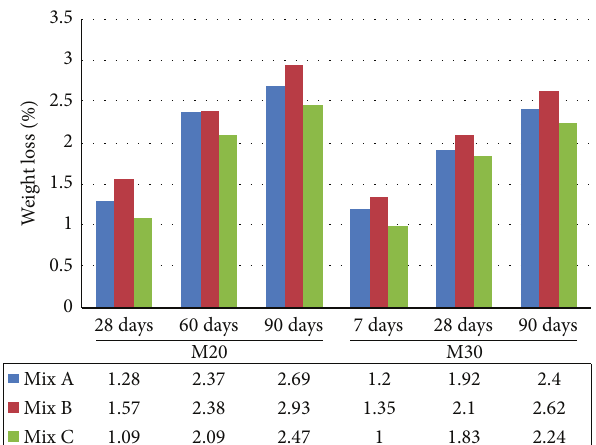
Figure 14: Comparative sulphate attack of Mix A, Mix B, and Mix C of M20 and M30